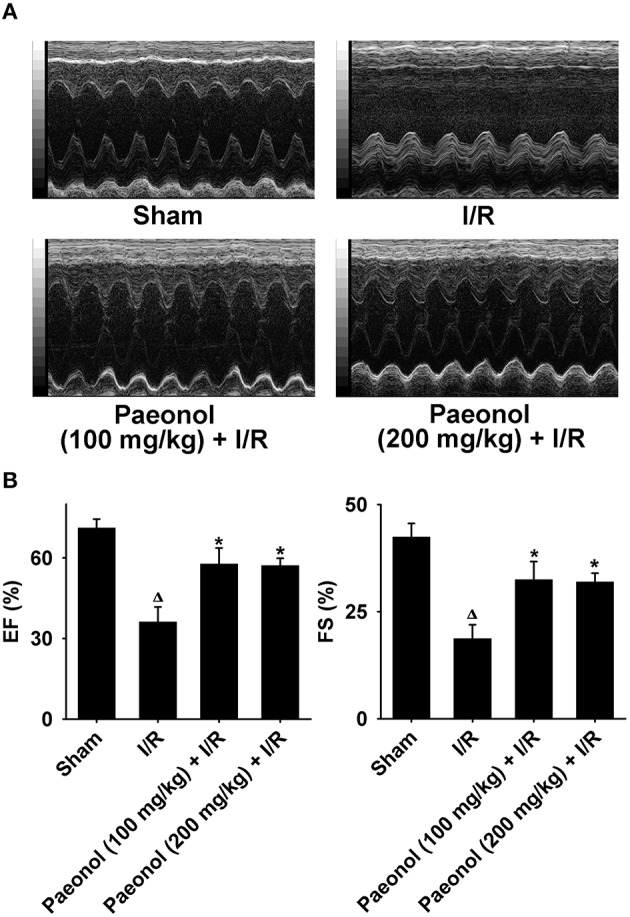
Effect of paeonol on cardiac function evaluated by echocardiography. (A) Representative echocardiographic images of the four groups after the surgical procedure. Each image shown is 1-s duration of the entire echocardiograph. (B) Percentage of ejection fraction (EF) and fractional shortening (FS) affected by paeonol. Sham group (n = 9), I/R group (n = 9), paeonol (100 mg/kg) + I/R group (n = 8), paeonol (200 mg/kg) + I/R group (n = 8). *p < 0.05 compared with I/R group. Δp < 0.001 compared with sham group.